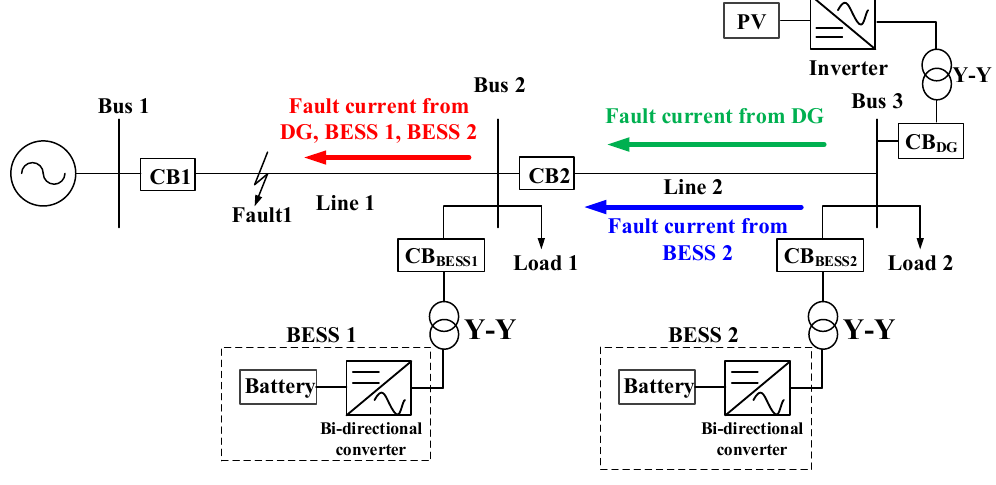
Figure 2. Flow of fault current.